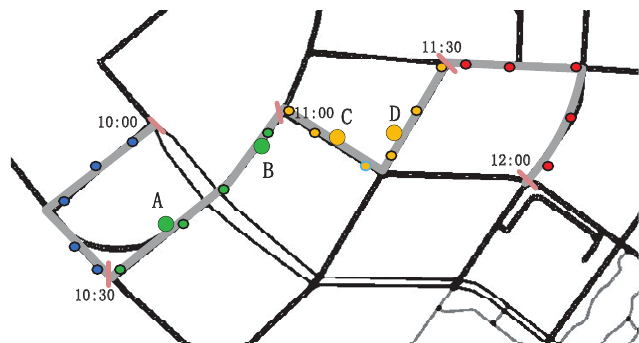
Figure 10. Illustration of Temporal Generalization. The gray line is the trajectory of a car in timeline from 10:00 to 12:00. In temporal generalization process, we set the temporal resolution to half an hour, and the path is divided into 4 periods marked by different colors. Points in the same period are considered undistinguishable. For example, A and B , C and D are undistinguishable, while A and C , B and D are distinguishable.